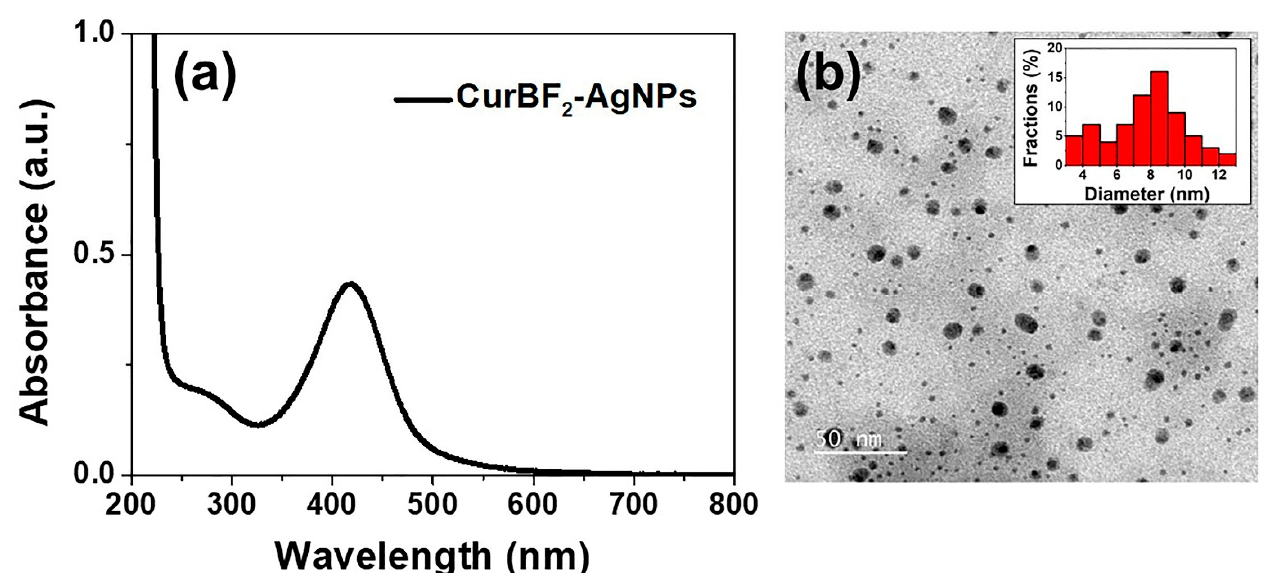
Figure 1. ( a ) UV–VIS spectrum of CurBF 2 -AgNPs, ( b ) TEM image of CurBF 2 -AgNPs, inset the average diameter of 7.75 ± 2.26 nm ( n = 70).